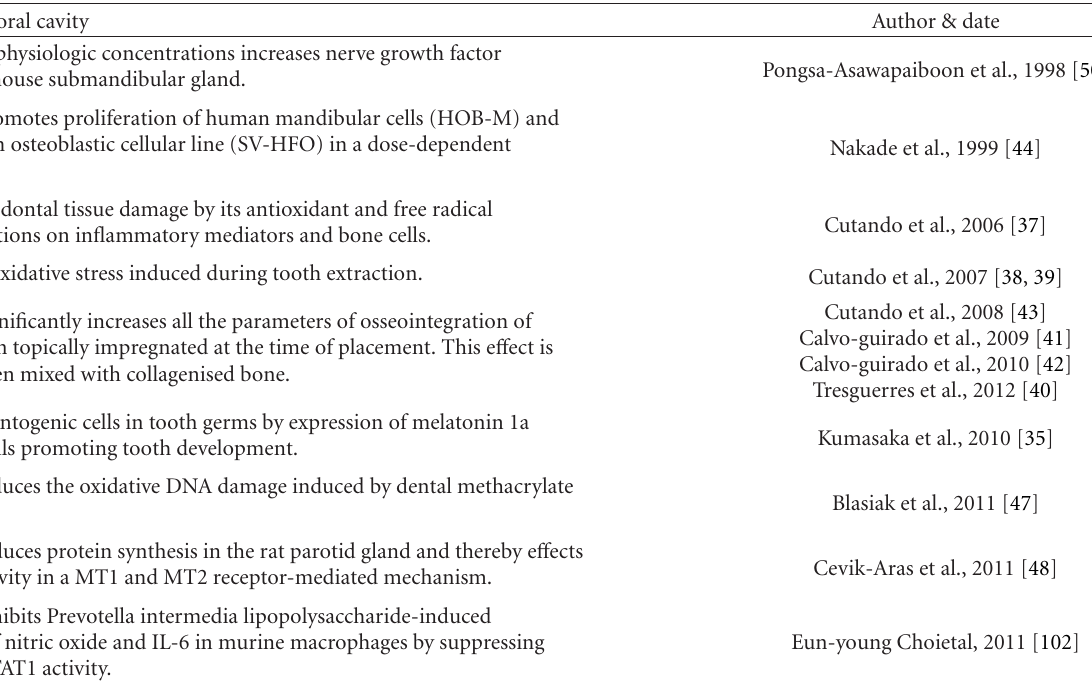
Table 2: E ff ects of melatonin in oral